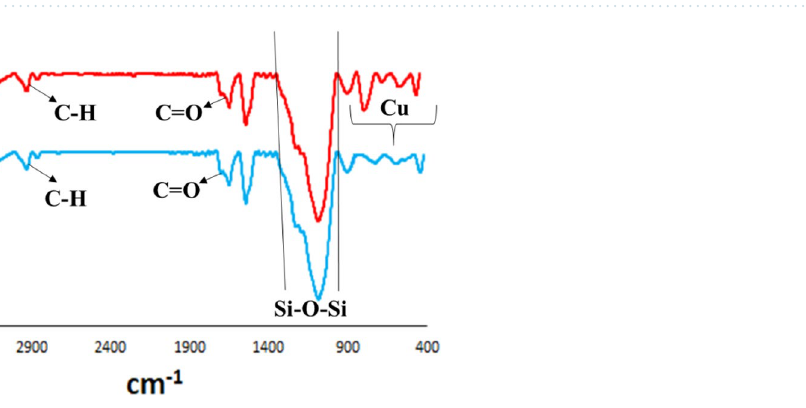
Figure 2. FTIR spectra of the APS-TDU-PMO ( a ) and Cu@APS-TDU-PMO ( 1 , b